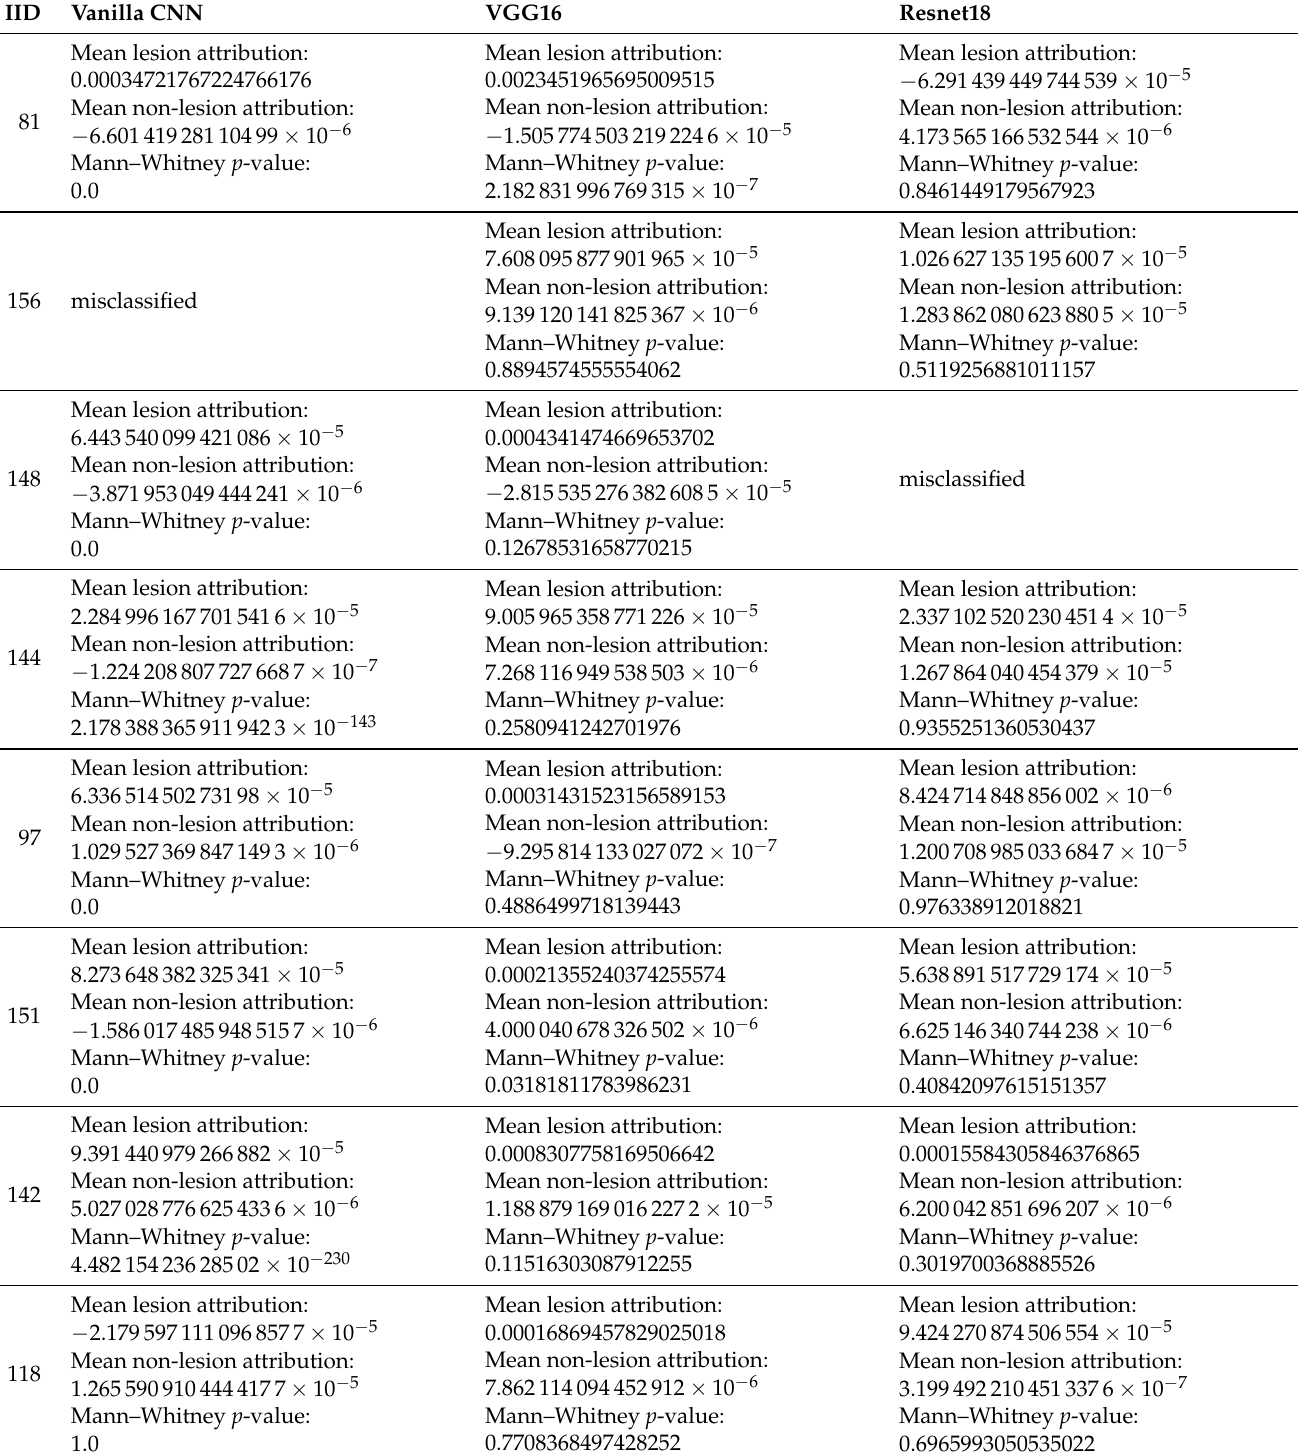
Table A1. Results per pair of model and test image. Images are identified by a unique code (IID). Results include the mean attribution score for lesion-related and non-lesion-related pixels and the p -value obtained for the Mann–Whitney test 1